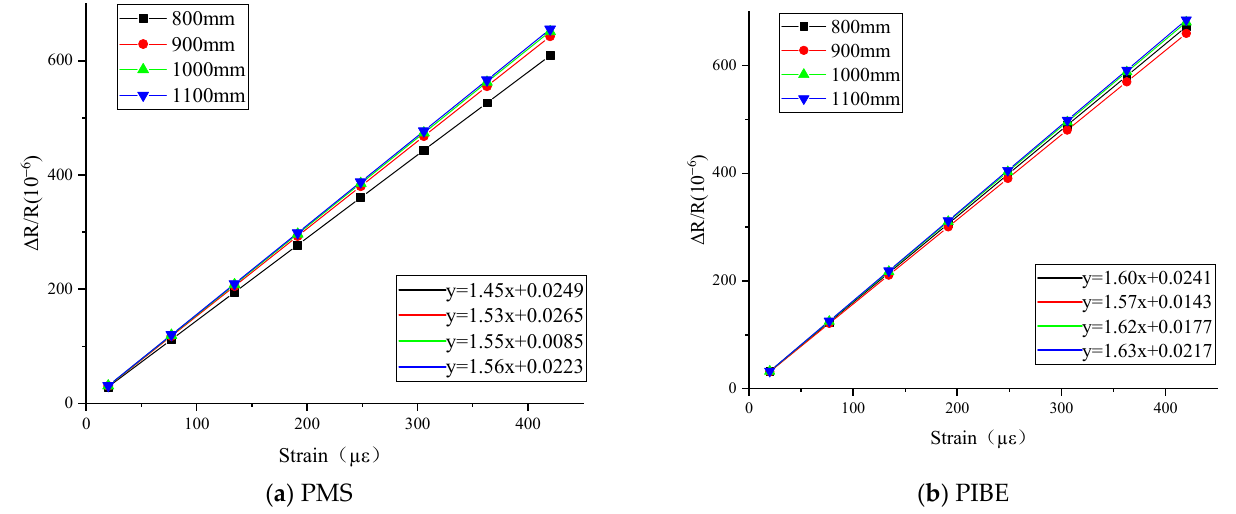
Figure 7. Results of thin-film strain sensors with different grid thicknesses prepared by PMS and PIBE.